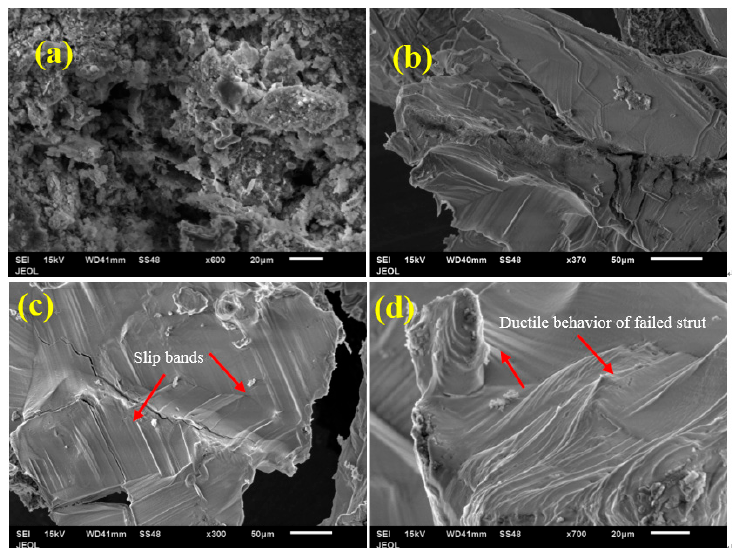
Figure 8. Fracture surface of Al-foam showing different morphologies of: ( a , b ) collapsed struts at different magnifications, ( c ) multiple slip systems, and ( d ) necking of the ductile strut.